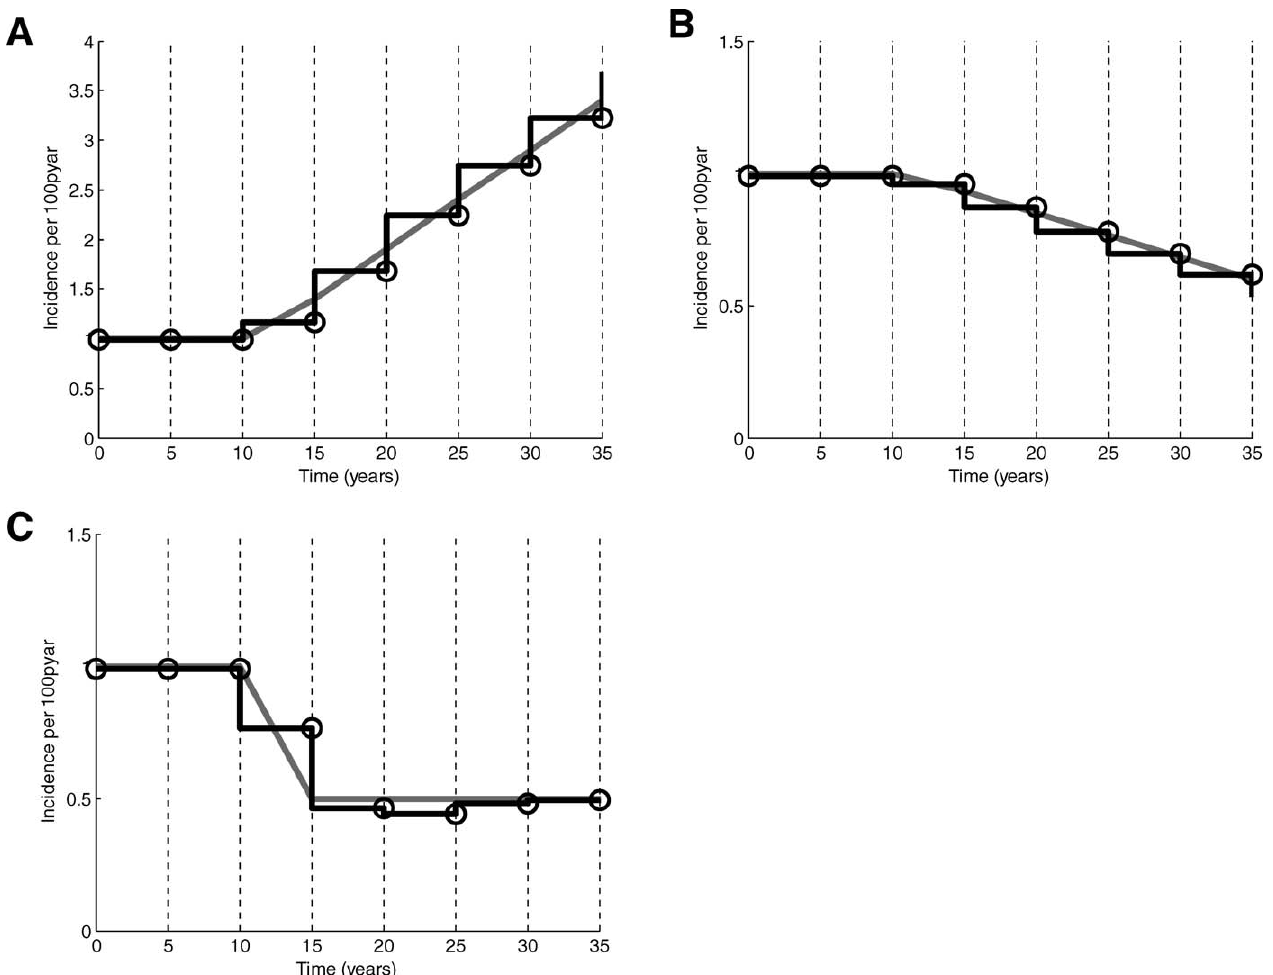
Figure 3. Comparison of True Simulated Incidence Rate (Grey Lines) and Estimates Using Either Method (Black Lines; Both Give Same Results) when True Incidence Increases Steadily (A), Decreases Steadily (B), or Decreases Suddenly (C) Vertical lines indicate when five-yearly serosurveys are done. Estimates of incidence are made at the time of the serosurvey (open circles) but relate to the preceding 5-y period.